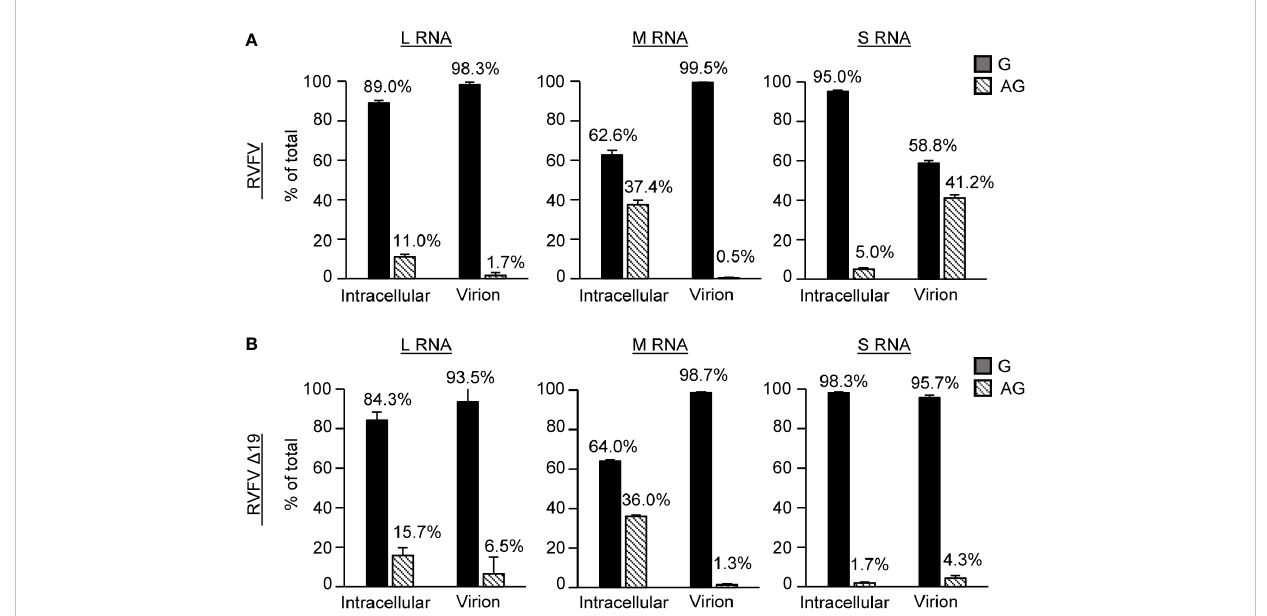
FIGURE 5 Pro fi le of viral RNA segments packaged into puri fi ed RVFV and RVFV D 19 particles. Proportions of genomic and antigenomic RVFV RNA segments in (A) RVFV and (B) RVFV D 19-infected cells and puri fi ed virus particles. Huh7 cells were infected with RVFV or RVFV D 19 at an MOI of 2. Intracellular lysates and culture supernatants were collected at 8 h p.i. Virus particles released in the culture supernatant were puri fi ed by sucrose gradient ultracentrifugation. The copy numbers of genomic (G) and antigenomic (AG) L, M, S RNAs in intracellular lysate and in puri fi ed virions were determined by strand-speci fi c RT-qPCR. The proportions of genomic and antigenomic RNAs in virus-infected cells and in puri fi ed virions are represented as a percentage of total viral RNA for each segment. Data represent the means of biological triplicates, and error bars indicate the standard